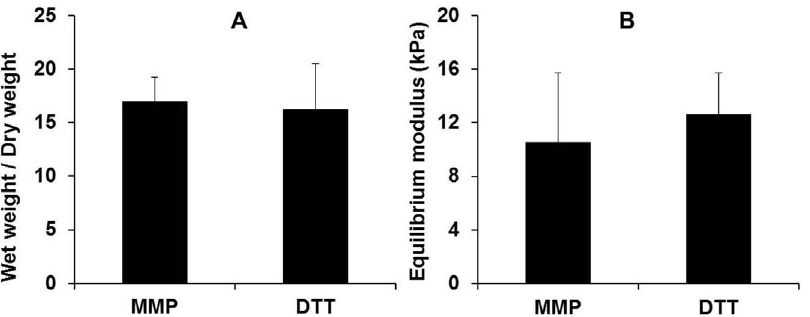
Figure 2. The physical properties of the hydrogels formed using different crosslinkers. (A) Weight degree of swelling (the ratio between the swollen wet weight and dry weight) and (B) equilibrium modulus of acellular hydrogels crosslinked using either MMP-cleavable peptides or MMP- insensitive DTT after 24 hours of equilibration in phosphate buffered saline.